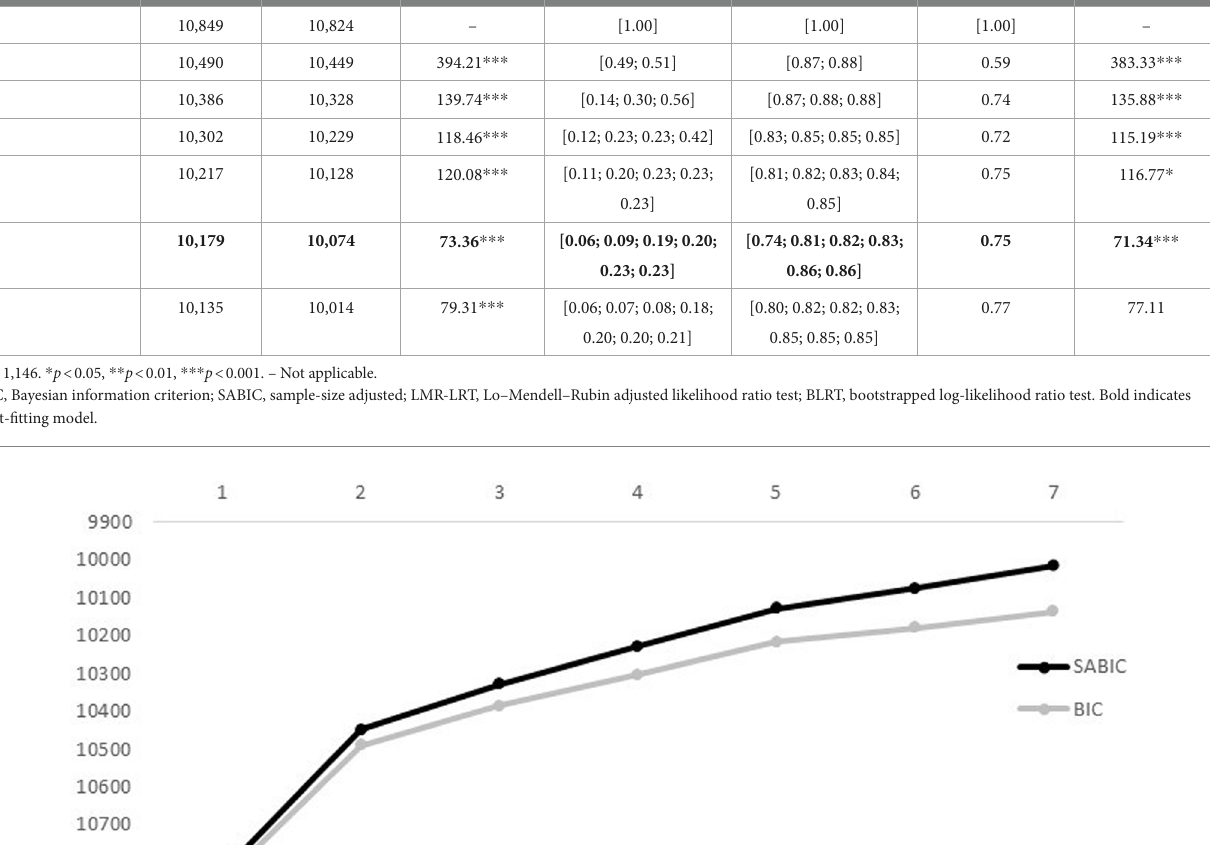
TABLE 2 Fit indices for the latent profile models based on the compensation characteristics. Solution